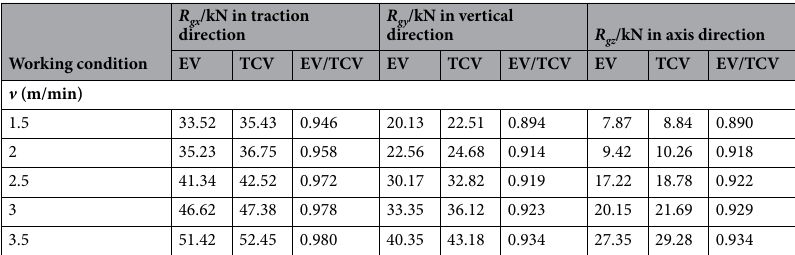
Working condition